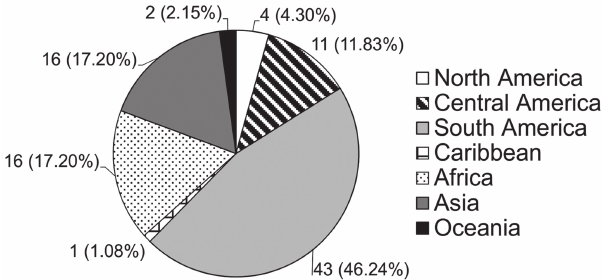
Fig. 3. Origin of non-native large fish species available among Brazilian hobbyists in the informal market.